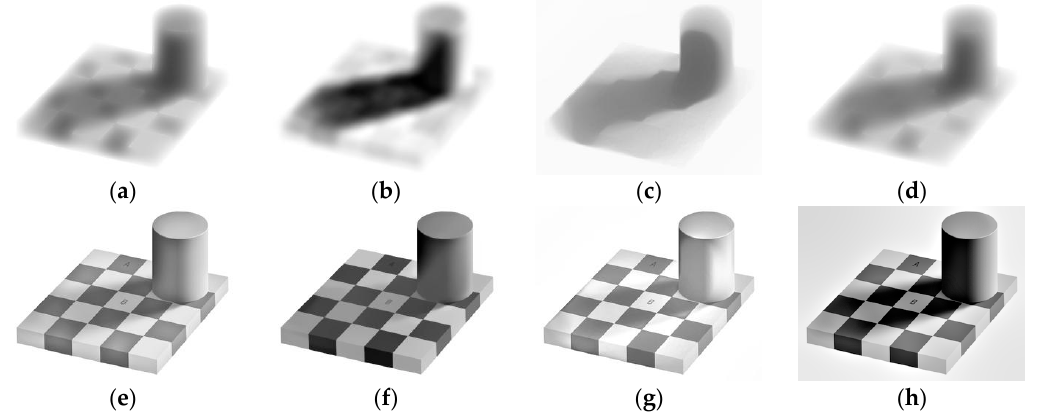
Figure 11. Illumination ( a – d ) and reflection ( e – h ) images. ( a , e ) Ng’s method; ( b , f ) HoTVL1; ( c , g ) proposed method; ( d , h ) multiscale Retinex. Table 3. Recovered intensity values for regions A and B of Figure 10a.